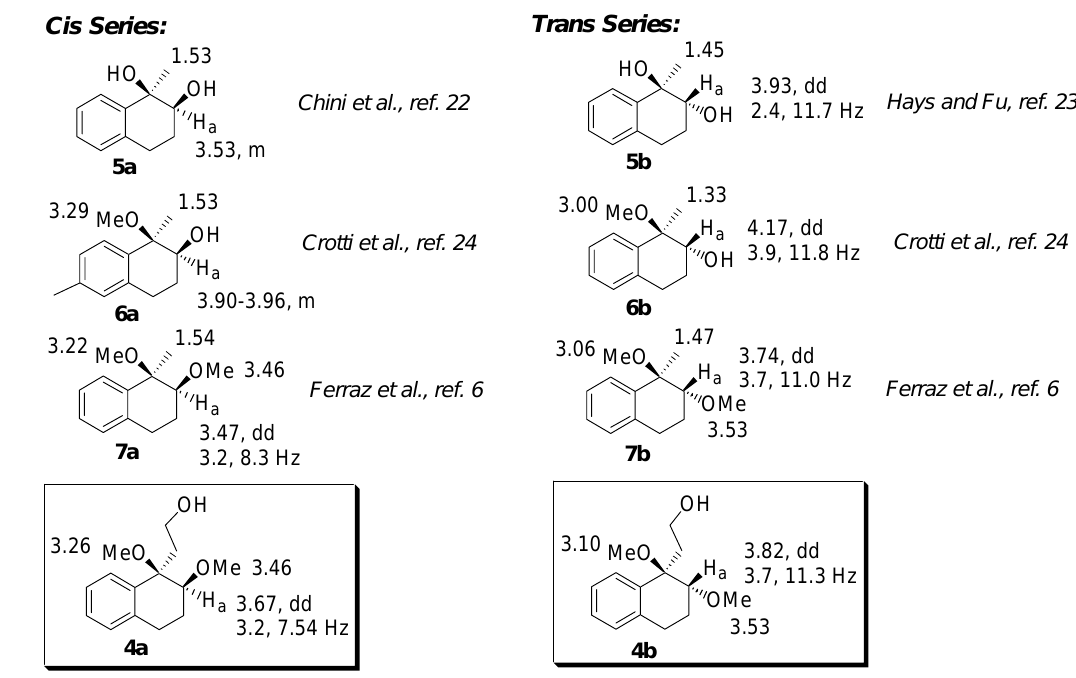
Figure 2. Selected chemical shifts of cis - and trans -dimethoxylated